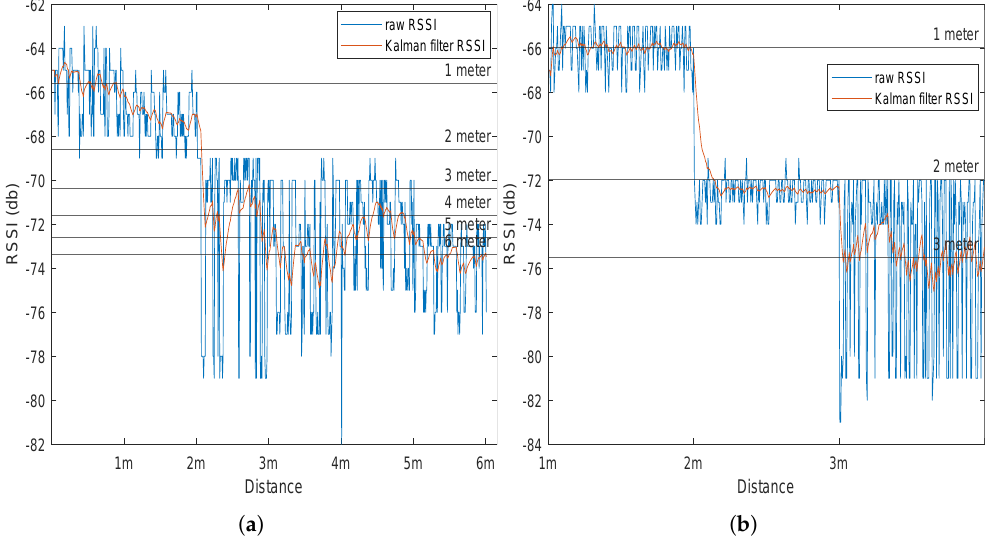
Figure 6. RSSI measured values at 1 m intervals against the predetermined threshold values vs, distance in an ( a ) outdoor environment, ( b ) indoor